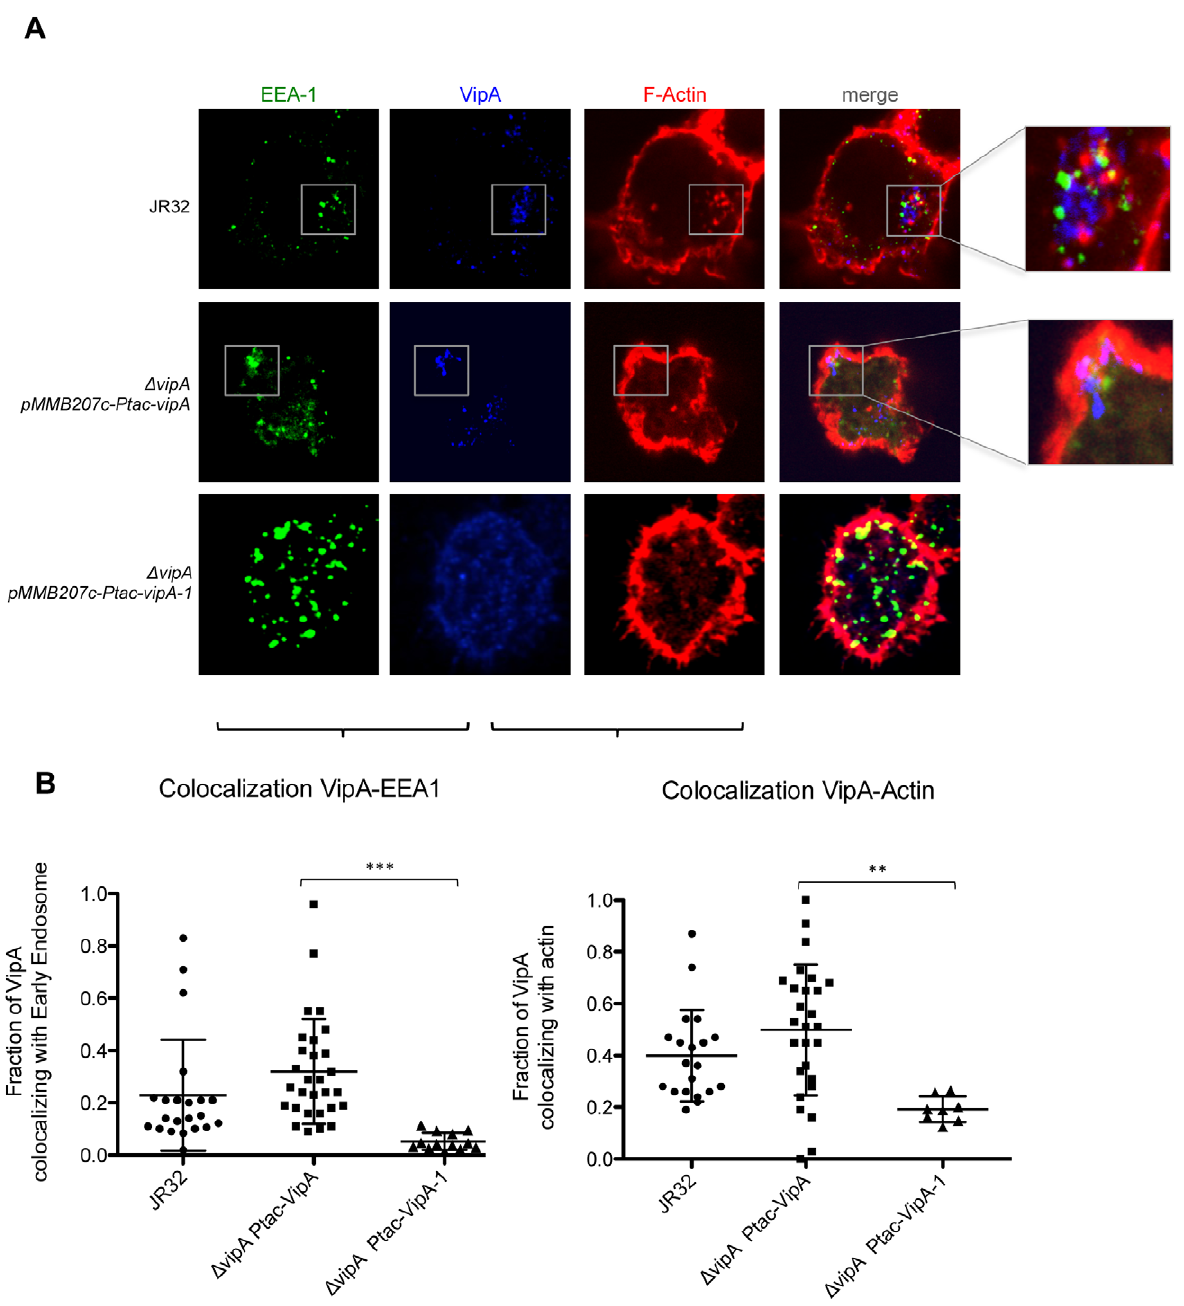
Figure 7. Colocalization of VipA with host cell early endosomes and actin in macrophage infection. A. THP-1 macrophages were infected as above (see Legend of Figure 6 and Materials and Methods). F-Actin was stained with Rhodamine-phalloidin and Early Endosomes using an a EEA-1 antibody. B. Quantification of colocalization between VipA and F-Actin or EEA-1 was performed by calculating the Manders coefficient using ImageJ and the Plugin JACoP (see Materials and Methods for details). The Manders coefficient corresponds to the fraction of VipA-GFP or VipA-1-GFP (blue signal) overlapping with each marker (green or red signal) divided by the total green signal in an image. Filled symbols represent cells expressing VipA-GFP (n . 15), open symbols cells expressing VipA-1-GFP, and bars indicate mean and standard deviation. Statistical analysis was performed with unpaired t test, and p values obtained are indicated (**, p , 0.01; ***, p , 0.001).